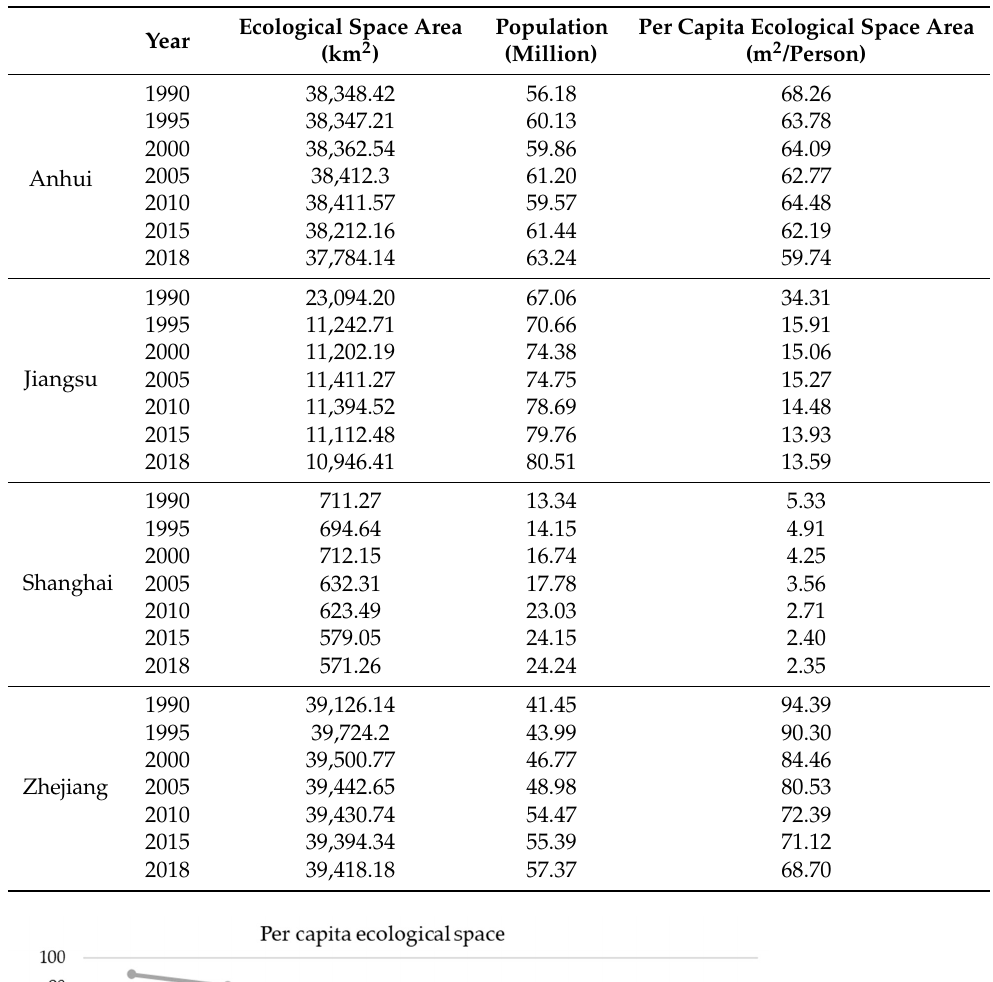
Table 5. Population and per capita ecological space of each Province in the Yangtze River Delta Urban agglomeration (population data from: http://www.stats.gov.cn/ accessed on 01 November 2022).